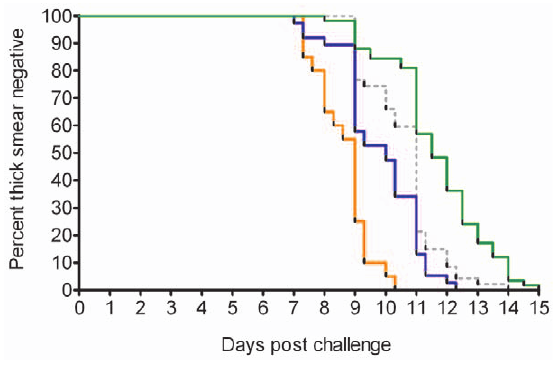
Figure 1. Time to microscopically detected parasitemia by cohort. Survival curve for four cohorts: RUNMC I (orange), RUNMC II (blue), USMMVP (interrupted grey line) and Oxford (green).